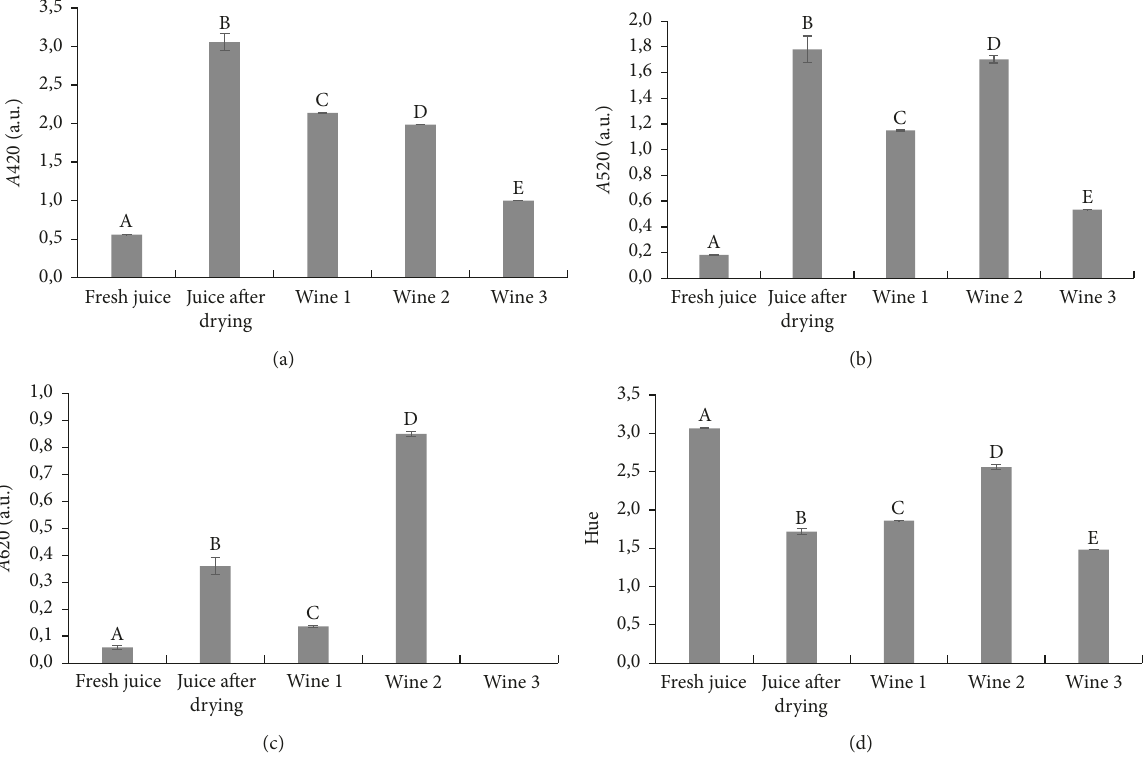
Figure 1: Changes in (a) absorbance at 420 nm (a.u.), (b) absorbance at 520 nm (a.u.), (c) absorbance at 620 nm (a.u.), and (d) hue for blueberry juices and wines. 𝑁 = 3 . Columns with different superscript letters are significantly different, 𝑝 = 0.05